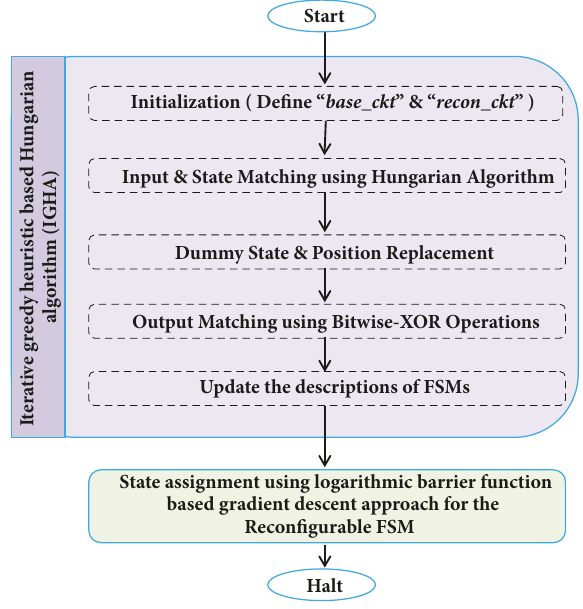
Figure 3: Flow chart for the improved iterative greedy heuristic based Hungarian algorithm